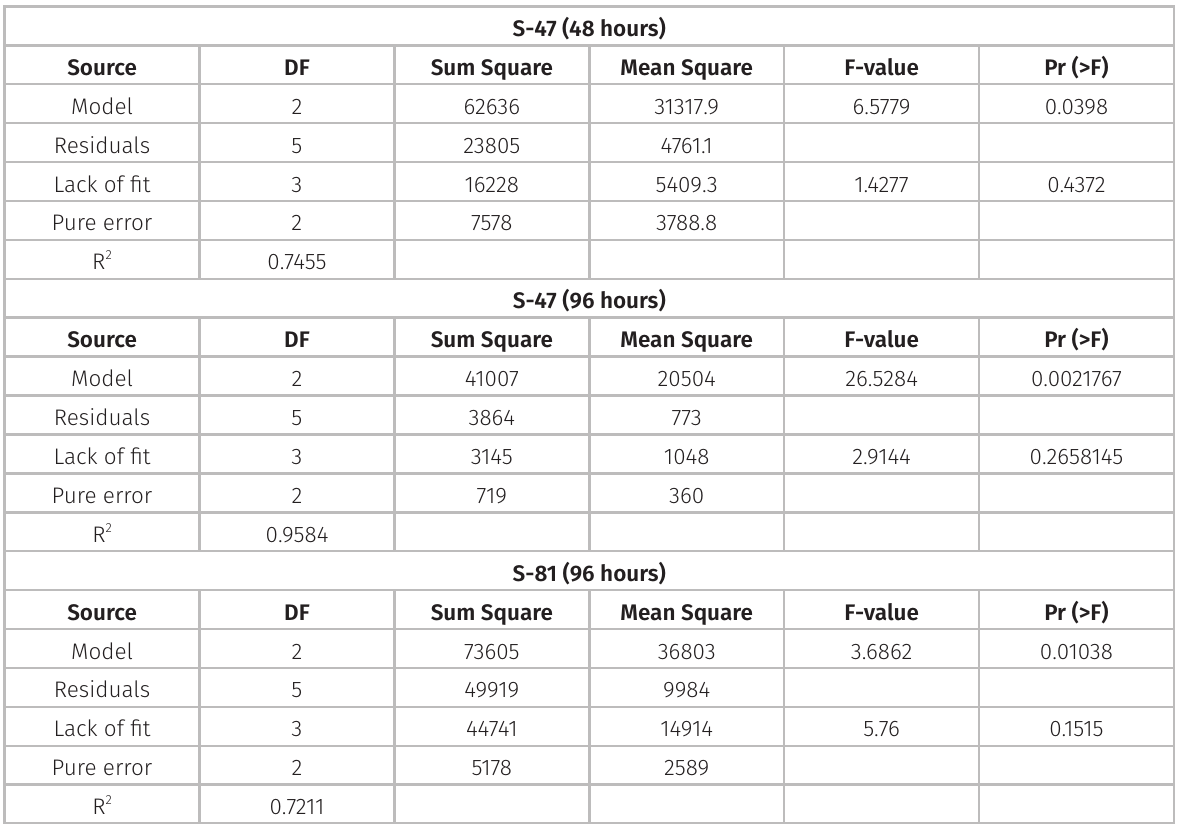
Table V. ANOVA for regression models for pH and